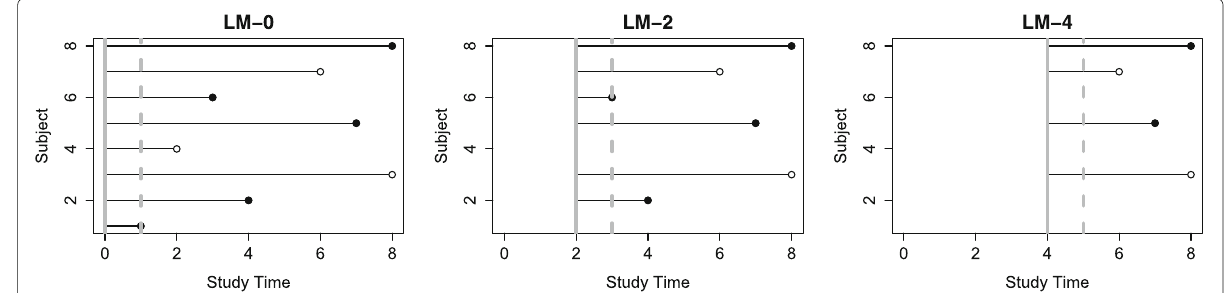
Fig. 2 An illustration of ROC C / D t mimicking landmark analysis. Solid circles represent events, and hollow circles represent censored subjects. For each landmark time point, subjects that remain alive are used for analysis. The solid vertical line represents this landmark analysis cutoff. The dashed vertical line represents the subsequent 1-year cutoff which is used to define cases versus